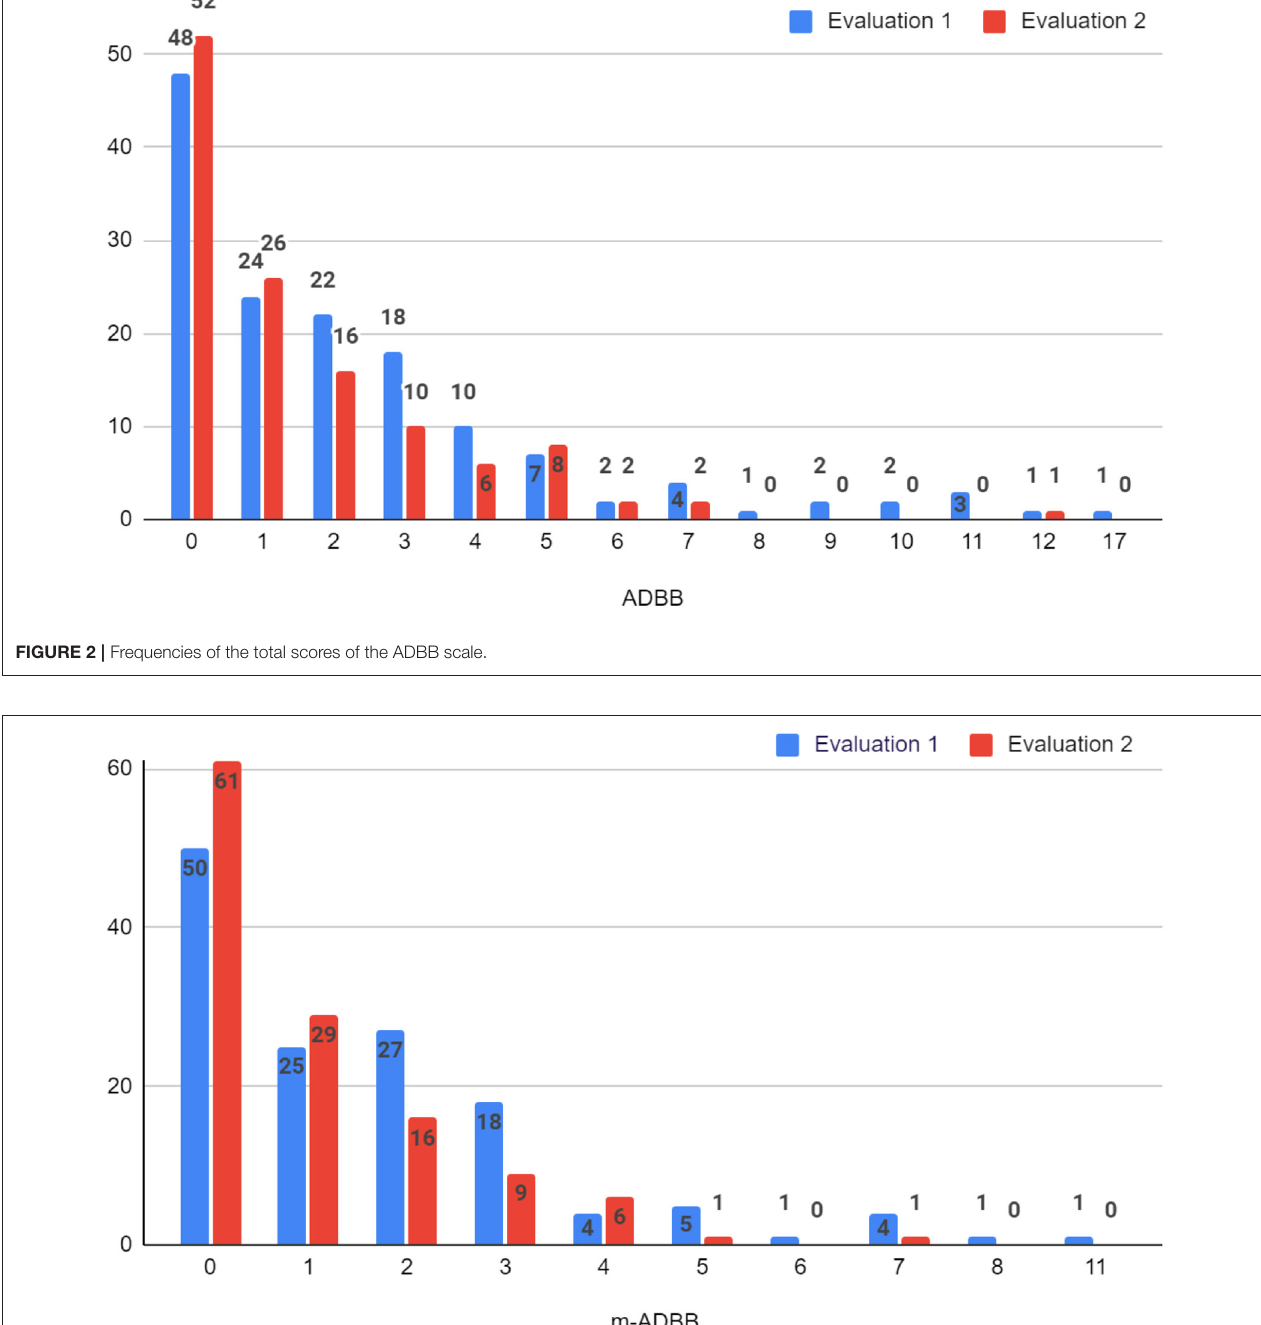
0.79; n = 123), and a good inter-rater agreement (kappa =